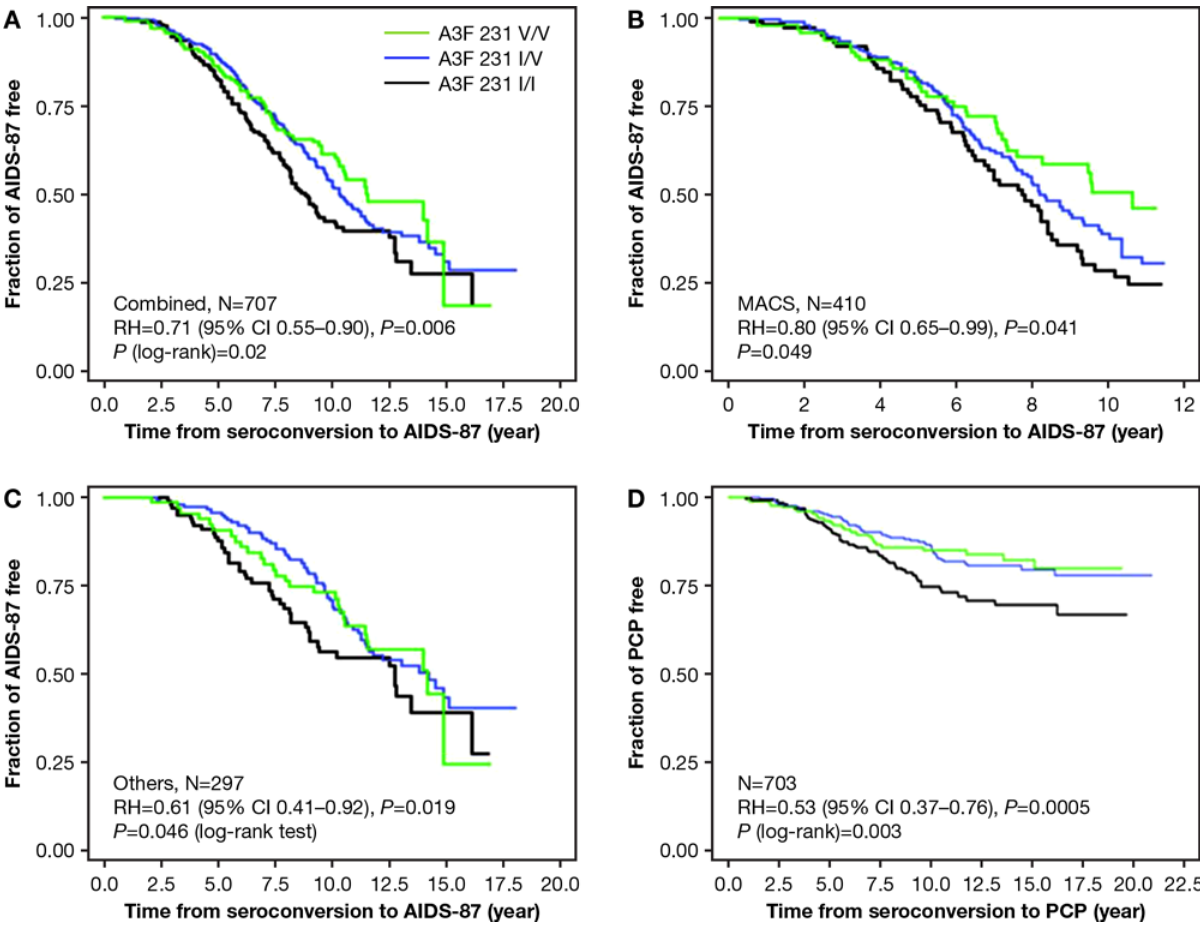
Fig 2. Genetic effect of A3F 231V haplotype on AIDS progression. Kaplan-Meier survival curves of A3F -231I/V genotype carriers progression to AIDS since HIV-1 infection in the (A) combined cohorts. (B) MACS cohort. (C) other cohorts. (D). Kaplan-Meier survival curves of A3F -231I/V genotype carriers for progression to PCP since HIV-1 infection in 703 seroconverter European Americans. RH and adjusted P values were obtained from a Cox proportional hazards model. P values for survival curves were obtained from a log-rank test.